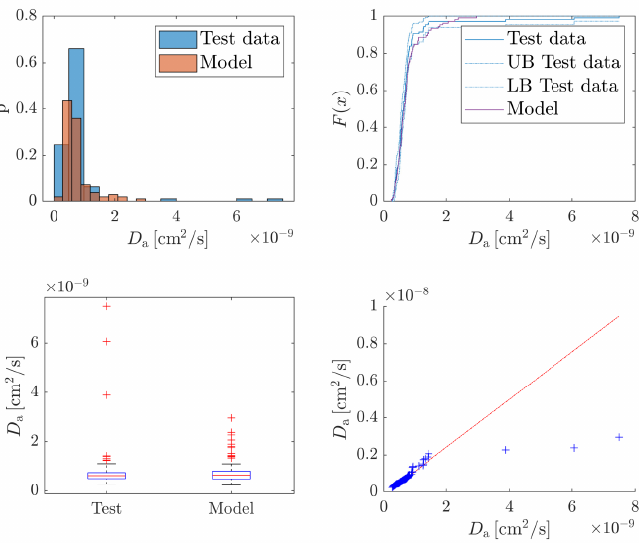
Figure 4. Validation of the marginal distributions for the parameter D a .